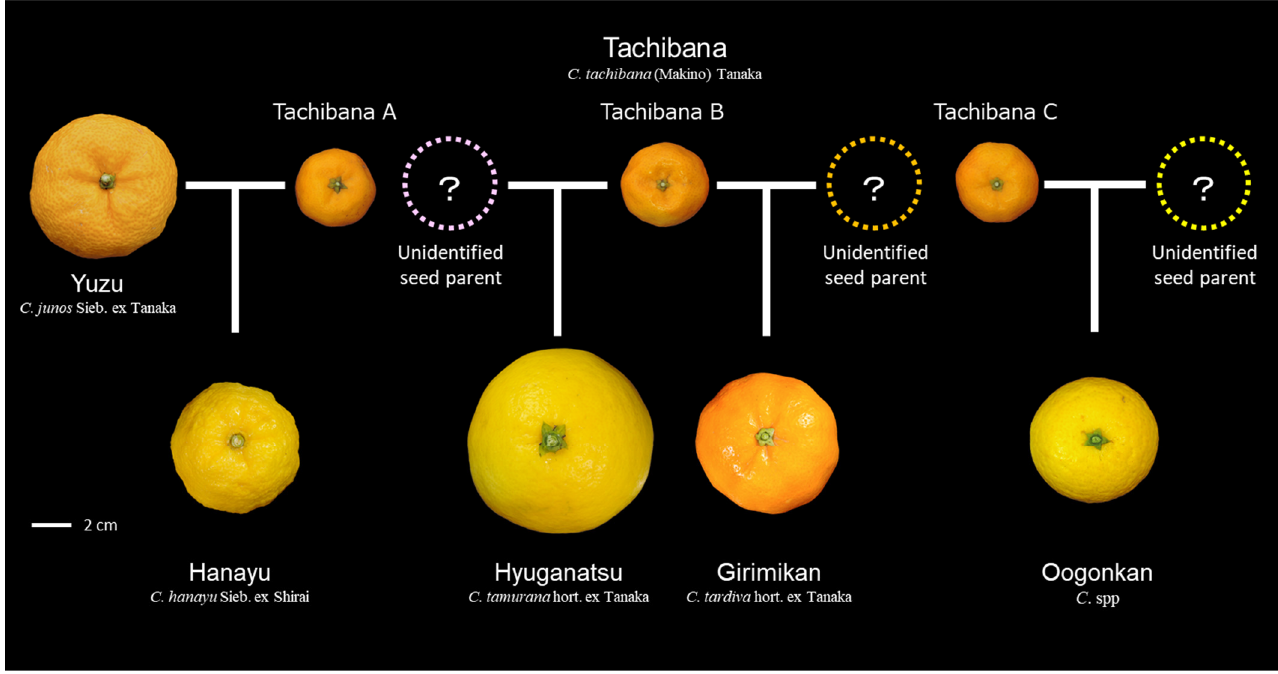
Figure 7. Pedigree of three tachibana strains.